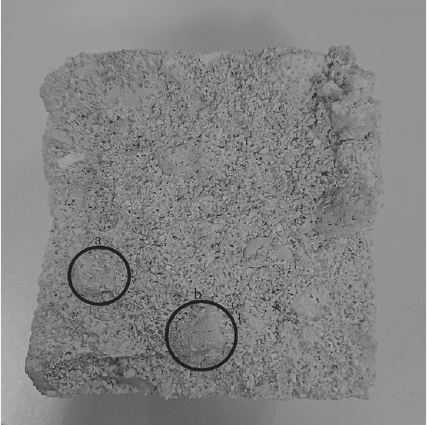
Figure 3: Schematic diagram of the sample: (a) broken particles; (b) complete particles.